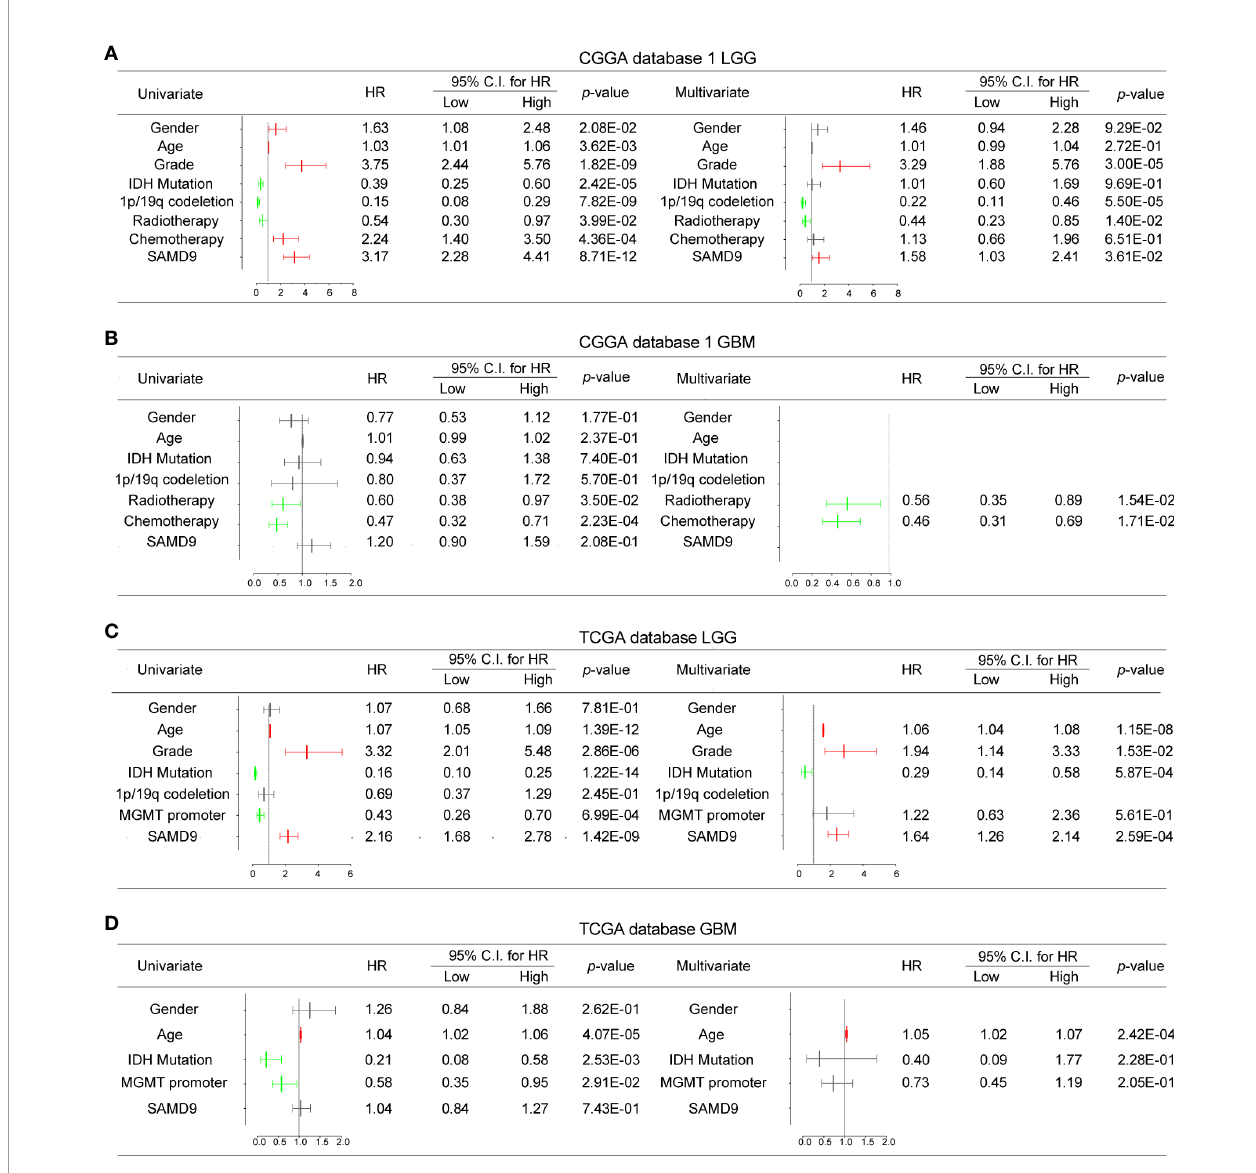
FIGURE 4 | Univariate and Multivariate Cox regression analyses and correlations with classic genetic alterations of SAMD9. (A) Univariate and Multivariate regression analyses of SAMD9 expression level and several related clinical variables in CGGA database 1 LGG, Red color indicates protective factor HR > 1, Green color indicates harmful factors HR < 1, Gray color represents HR crossing 1. HR of SAMD9 and Grade > 1, p < 0.0001. HR of 1p/19q codeletion < 1, p < 0.0001. HR of Radiotherapy < 1, p < 0.0001. (B) Univariate and Multivariate regression analyses of SAMD9 expression level and several related clinical variables in CGGA database 1 GBM, HR of Radiotherapy < 1, p = 0.0154. HR of 1p/19q codeletion < 1, p =0.0171. (C) Univariate and Multivariate regression analyses of SAMD9 expression level and several related clinical variables in TCGA database LGG. HR of SAMD9 > 1, p < 0.0001. HR of Grade > 1, p = 0.0153. HR of Age > 1, p < 0.0001. (D) Univariate and Multivariate regression analyses of SAMD9 expression level and several related clinical variables in TCGA database GBM. HR of Age > 1, p <